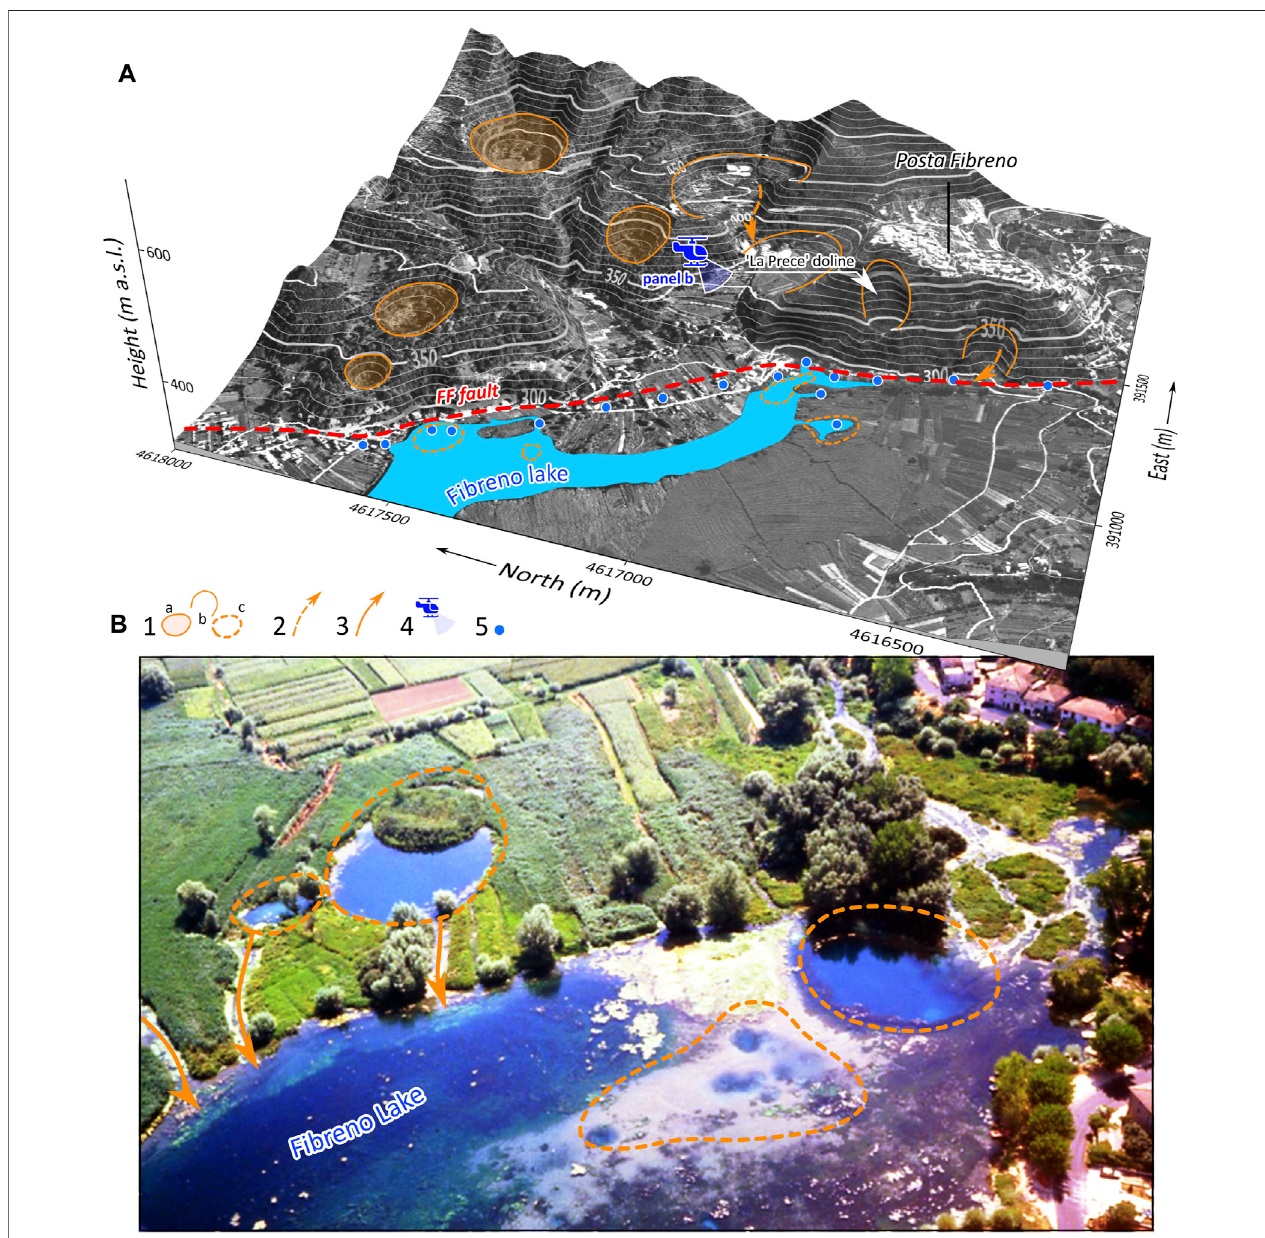
FIGURE 8 |(A) 3D view ofthe Fibreno lake area (the dashed green rectangle in Figure 4A ), identifying dolines, springs and the Fibreno fault. (B) Helicopter view of part of the Fibreno lake, where hypogean karst processes are evident. Key to the legend: 1) Dolines or doline group (a) closed, (b) open, (c) submerged; 2) Dry valley. 3) Drainage path (panel b); 4) Location and orientation of the picture in panel b; 5)